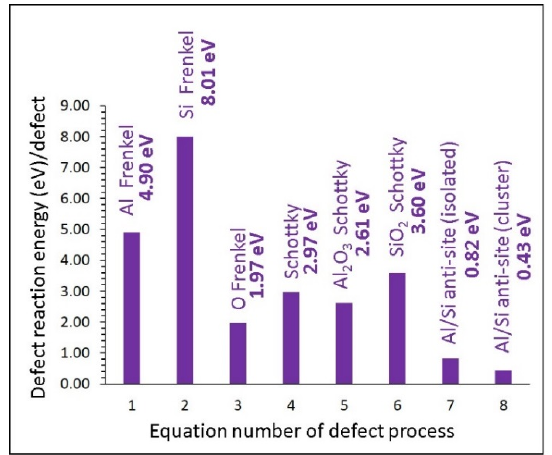
Figure 2. Defect reaction energies for different defect processes.